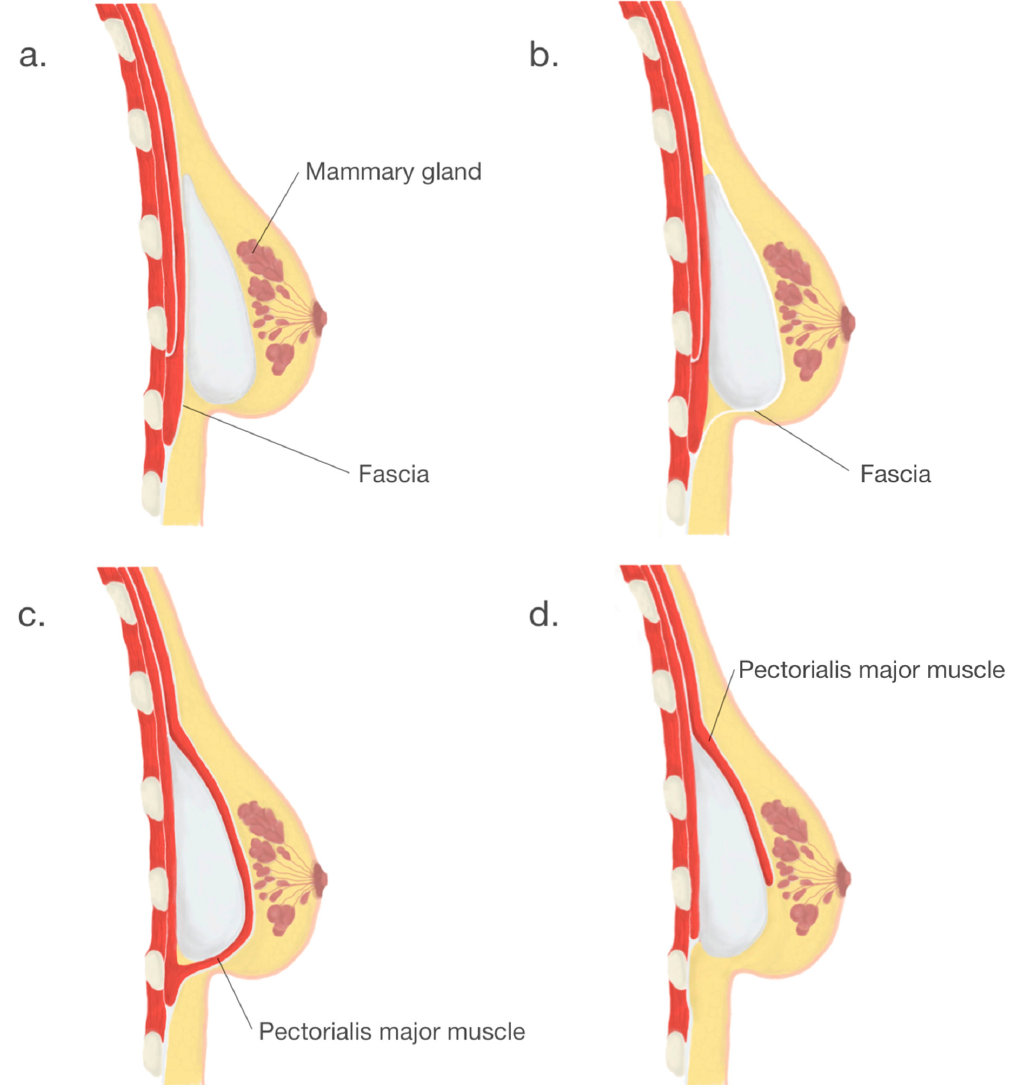
Figure 4. Breast implants placement locations: ( a ). subglandular, ( b ). subfascial, ( c ). submuscular, ( d ). dual—plane.